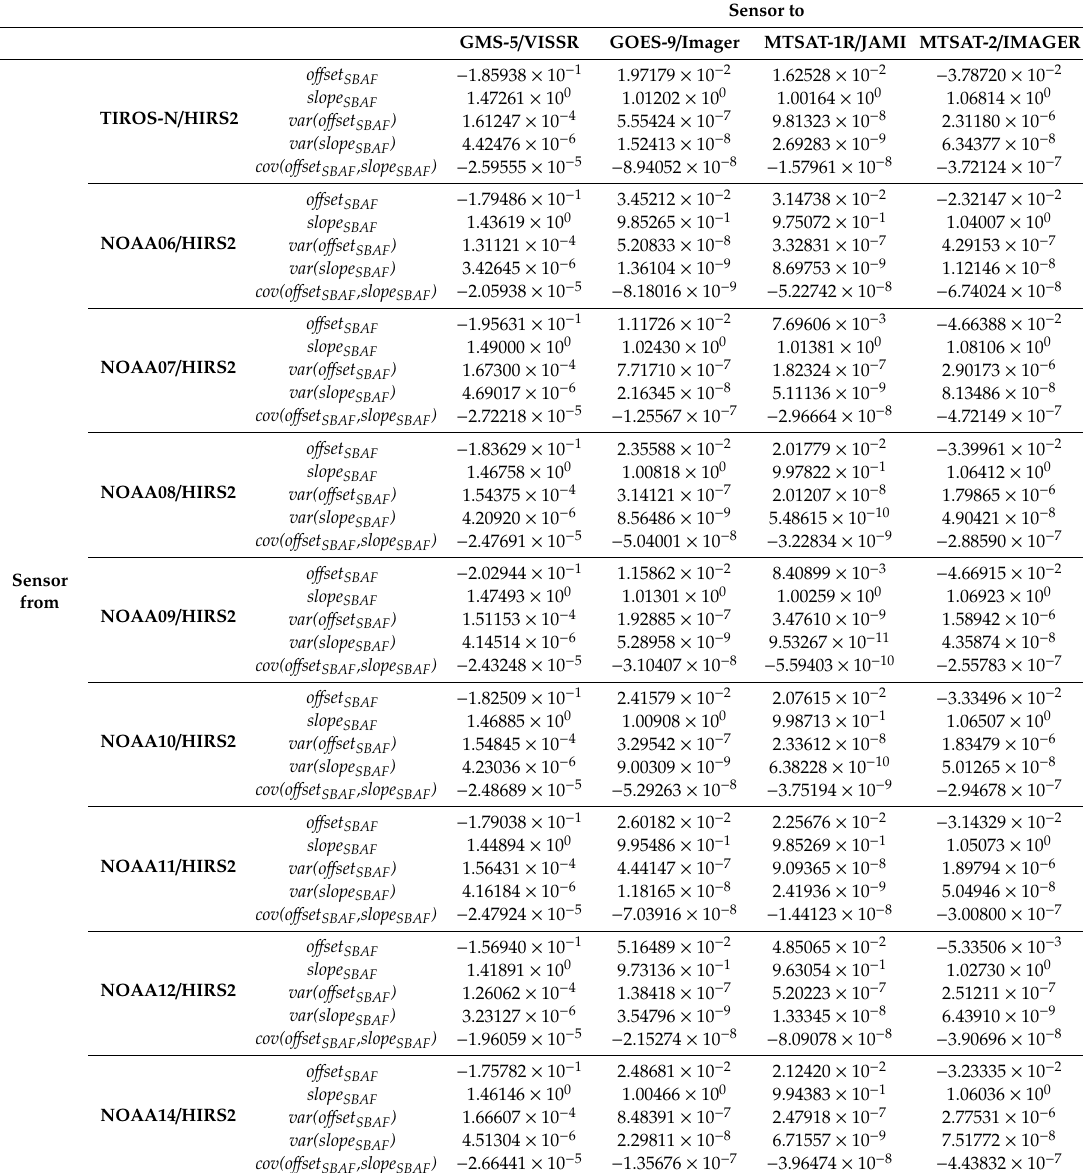
Table A2. SBAFs for the WV channel radiances from channel 12 on HIRS2 to those of the WV channel on the historical JMA’s satellites (unit: mW / (m 2 sr cm − 1